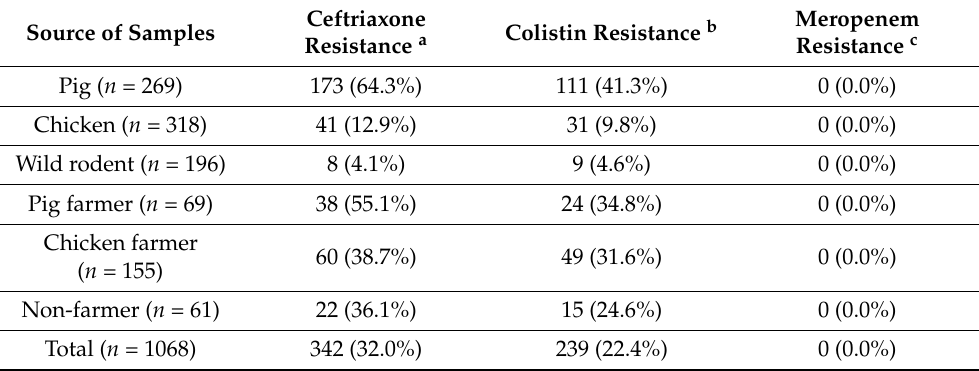
Table 1. Prevalence of ceftriaxone, colistin, and meropenem resistance in Escherichia coli and Klebsiella species isolated from samples collected from various animal and human sources. Ceftriaxone Meropenem Source of Samples Colistin Resistance b Resistance a Resistance c 173